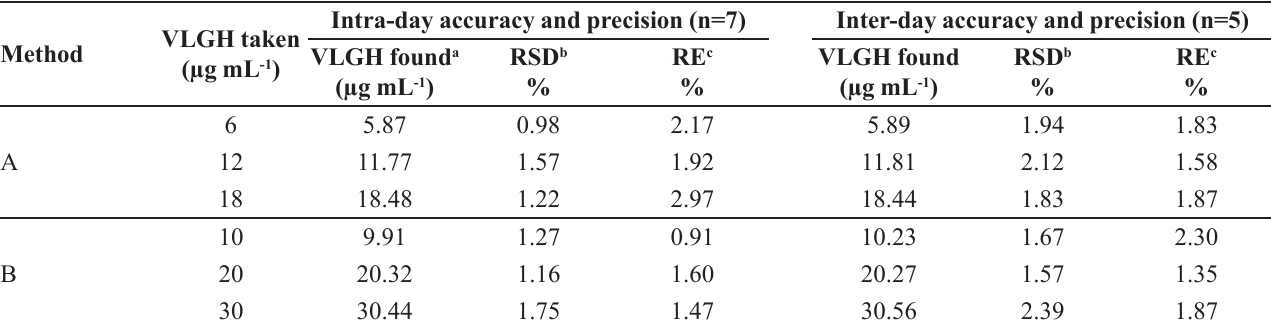
TABLE II - Evaluation of intra-day and inter-day accuracy and precision